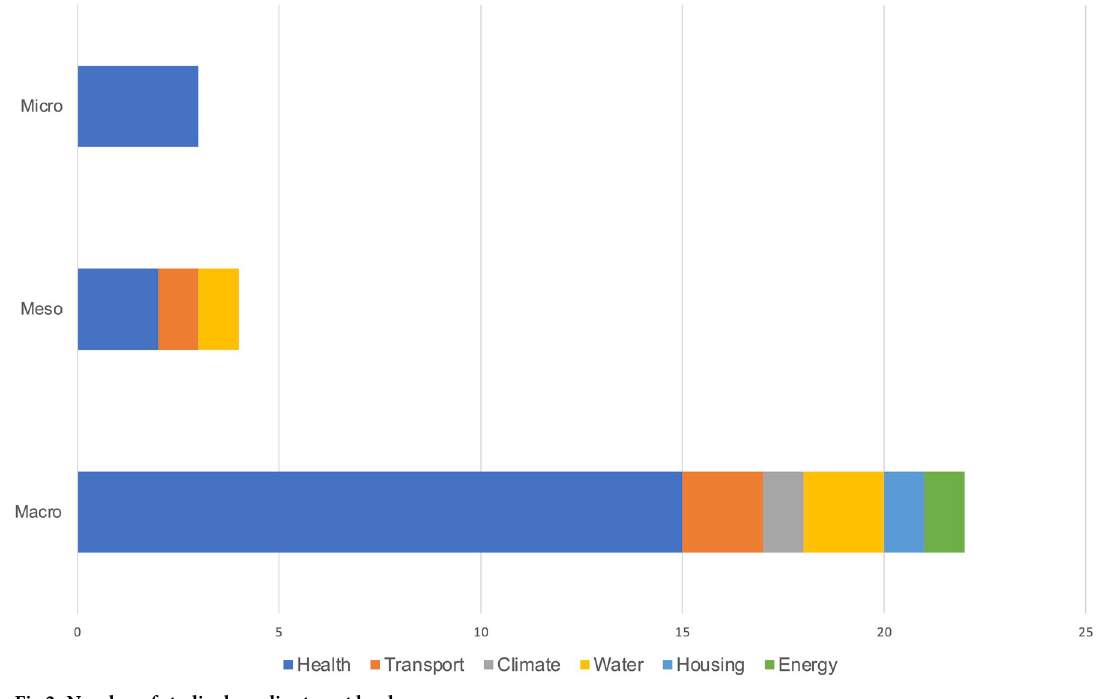
Fig 2. Number of studies by policy target level.